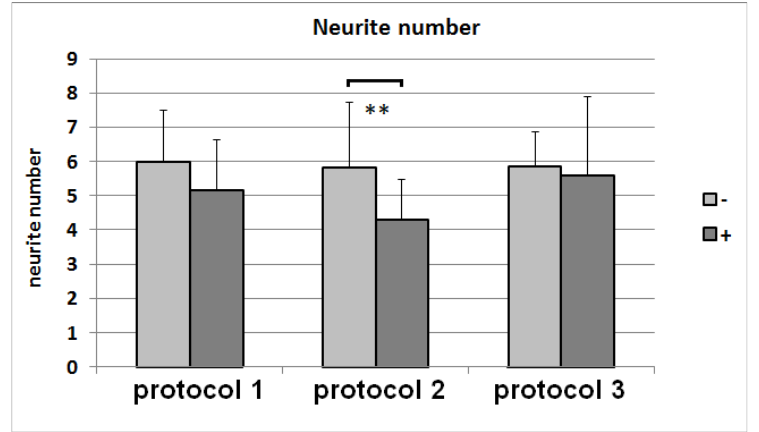
Figure 8. Numbers of neurites on NG108-15 cells after cultivation with media from Protocols 1, 2, and 3, with (+) and without ( − ) conditioning with predifferentiated ASCs. The mean value and standard deviation for each condition are shown. **: p -value < 0.01.